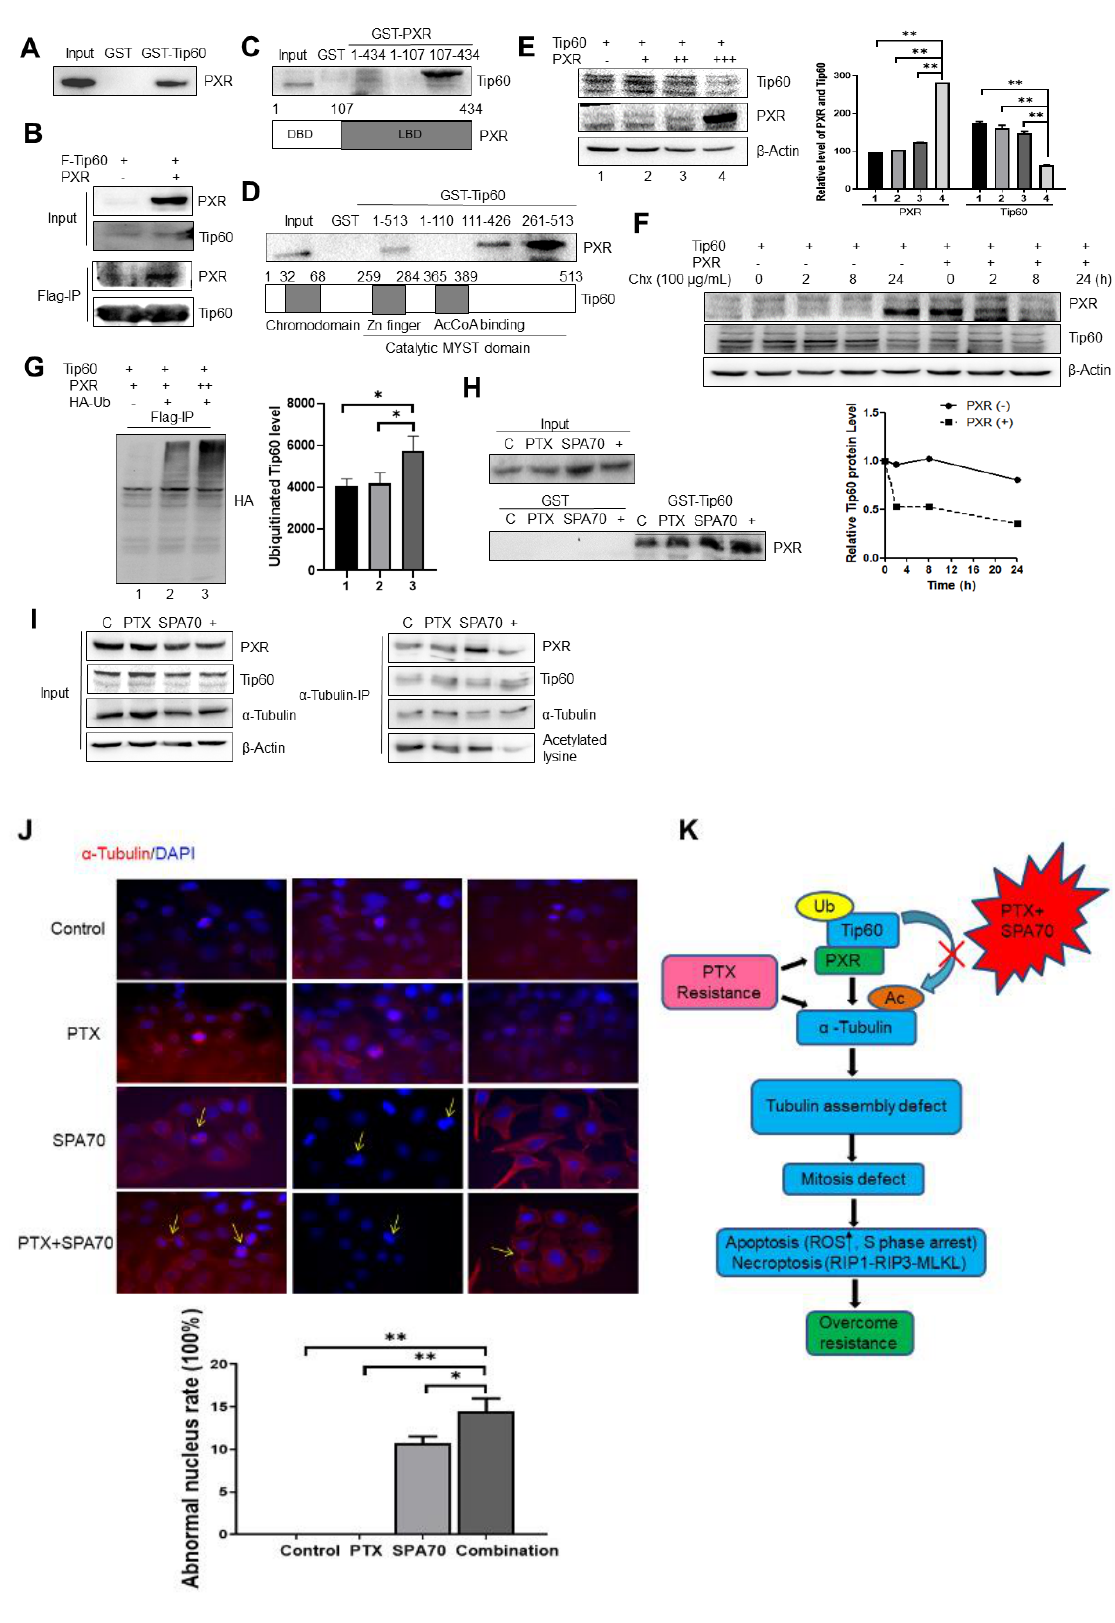
Figure 3. PXR interacted with Tip60 and PXR-degraded Tip60 was implicated in PTX-resistance mechanisms. ( A ) GST-Tip60 precipitated in vitro translated PXR. A total 20 μL of glutathione aga- rose conjugated GST-Tip60 or GST was incubated with 5 μL of in vitro translated PXR for GST- pulldown assays. ( B ) Reciprocal co-IP assay revealed that PXR interacted with Tip60. H1299 cells were co-transfected with FLAG-Tip60 (3 μg) and PXR (3 μg), and 1 μg of the FLAG antibody was used to perform the assay. ( C ) Ligand binding domain of PXR (107 – 434 aa) was required for Tip60 binding. PXR fragments (1 μg) were conjugated with GST and incubated with in vitro translated Tip60 for GST-pulldown assays. ( D ) Catalytic MYST domain of Tip60 binds with PXR. Tip60 trun- cated proteins (1μg) conjugated with GST agarose beads and incubated with in vitro translated PXR